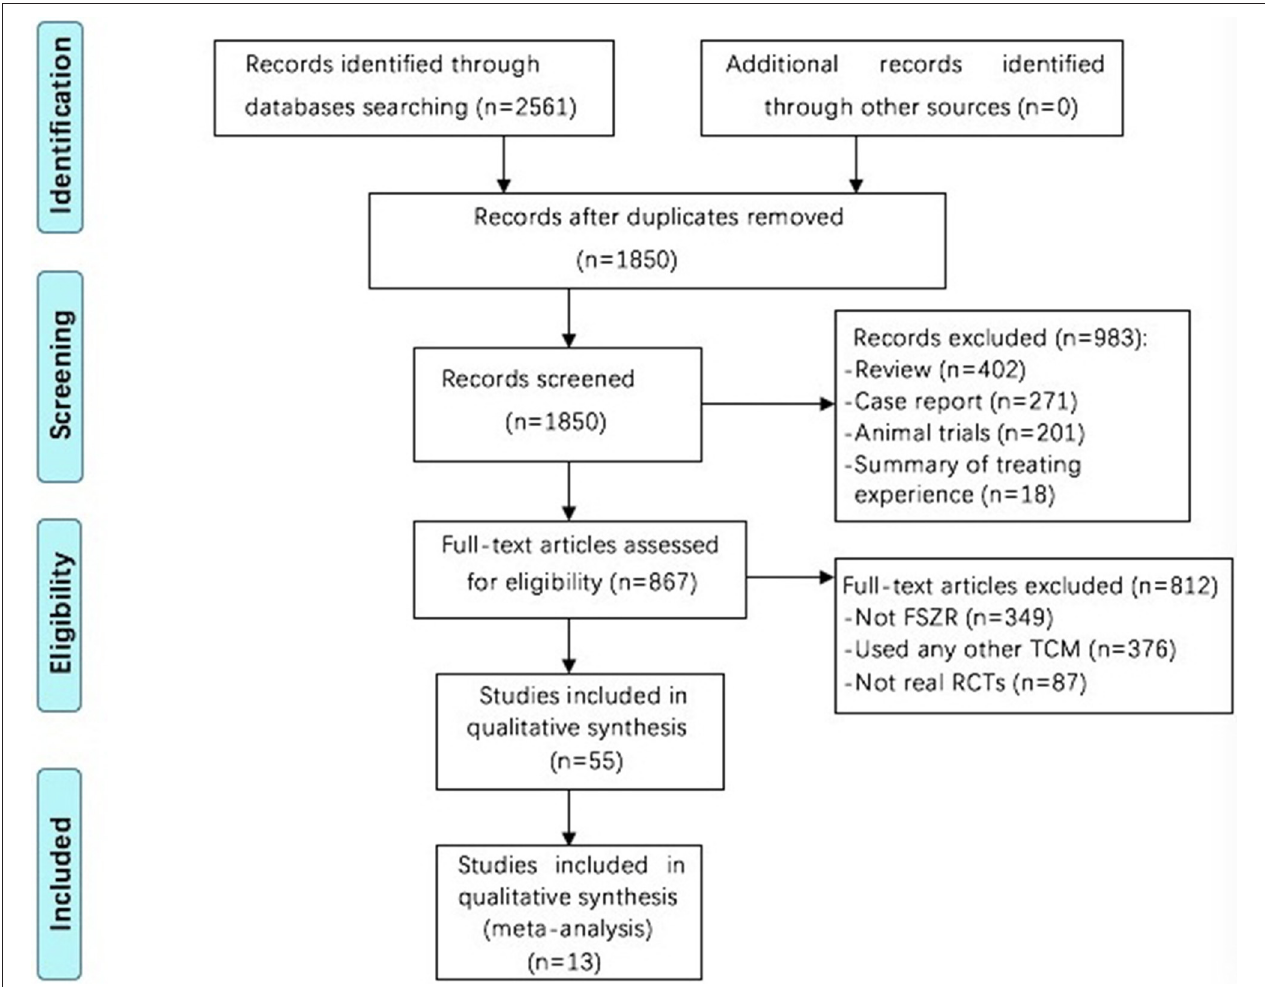
FIGURE 1 | Flowchart of study screening. FSZR, Chinese formulae that contains suanzaoren. TCM, Traditional Chinese medicine; RCTs, randomized controlled